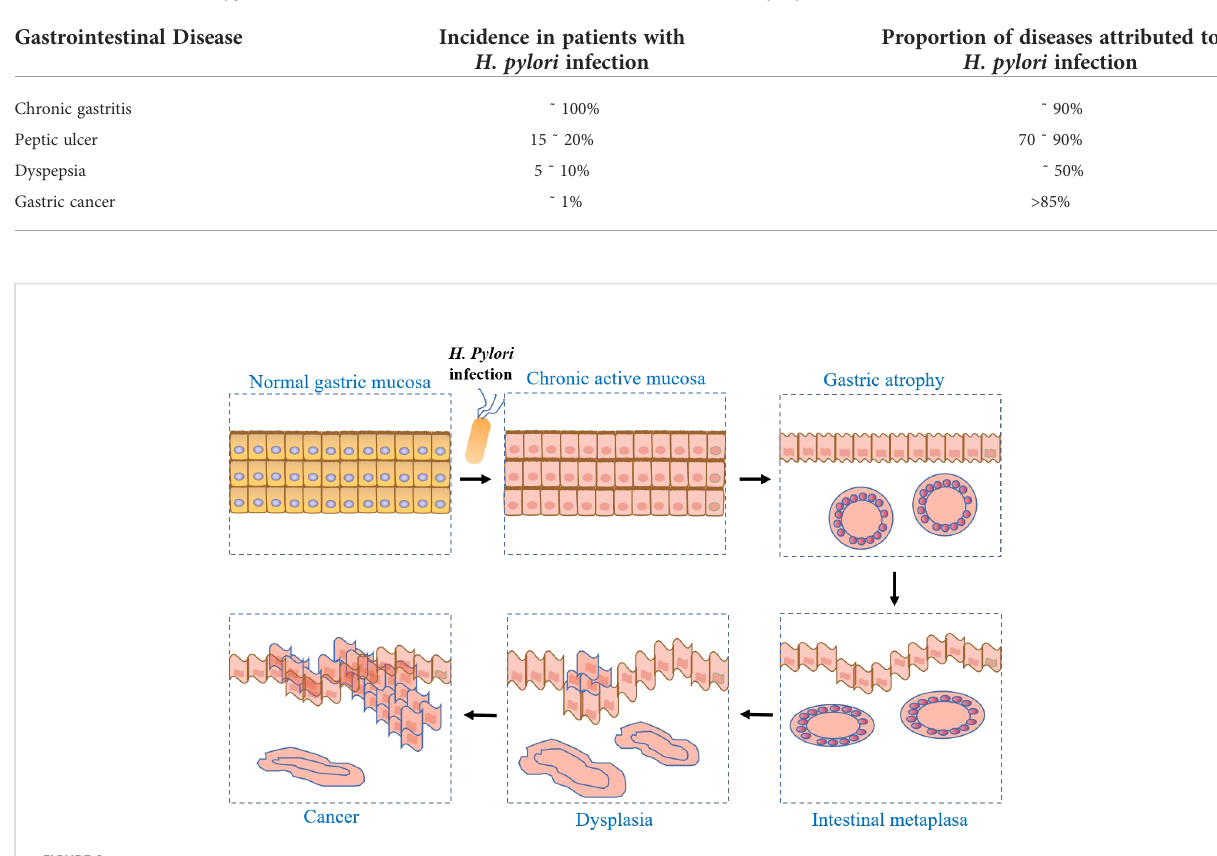
FIGURE 2 Disease progression pattern of H. pylori infection promoting gastric cancer: chronic active gastritis occurs after infection of normal gastric mucosa with H. pylori , through progressive development of atrophic gastritis, intestinal chemosis, heterogeneous hyperplasia, and fi nally gastric